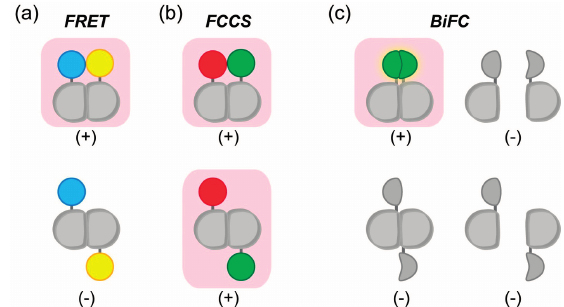
Figure 4. Detection of orientation-dependence or -independence of dimer formation by FRET, FCCS, or BiFC. Magenta background color and (+)/( − ) indicates signal emission in each methodology; ( a ) Restriction of FRET effect in dimerization depending on the tagging position of fluorescent molecule. Blue and yellow colors indicate FRET donor and acceptor, respectively; ( b ) Despite the tagging positions of the fluorophores, FCCS can detect dimerization. Green and red colors indicate fluorescence tag; ( c ) In addition to monomeric state (right top and bottom) with no fluorescence, not-appropriate tagging position of the fragments also shows no fluorescence (left bottom). In BiFC, as in FRET, only the appropriate positioning of the protein domains results in fluorescence (green color, left